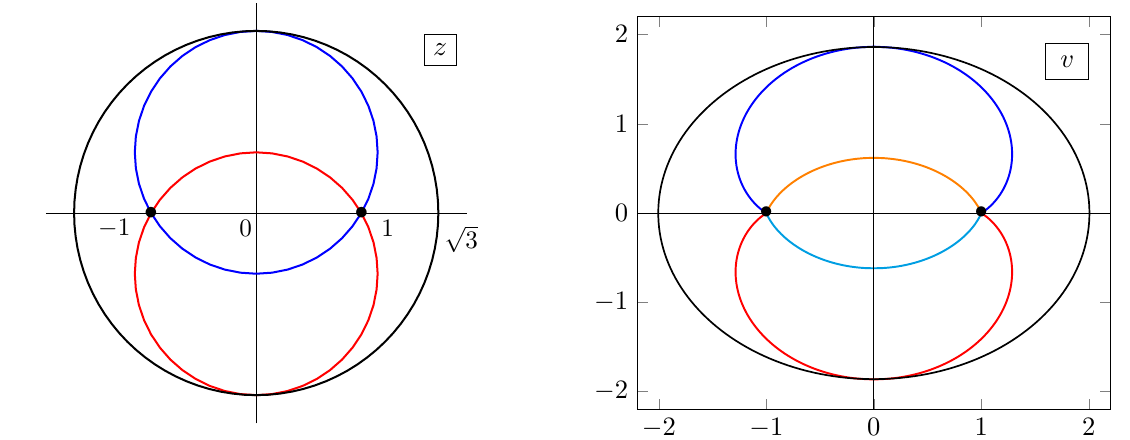
Figure 8. Candidate curves of marginal stability in the u = 0 slice for SU(3) . In the left panel, the i √ curves are circles of radius 2 √ centered at in the z -plane, and plotted in blue and red. In the ± 3 3 right panel, the image of the blue circle is shown in blue and cyan, while the image of the red circle is shown in orange and red. In both panels, the Argyres-Douglas points are indicated by bold black dots, while the K = 0 curve where the Kähler potential vanishes is plotted in